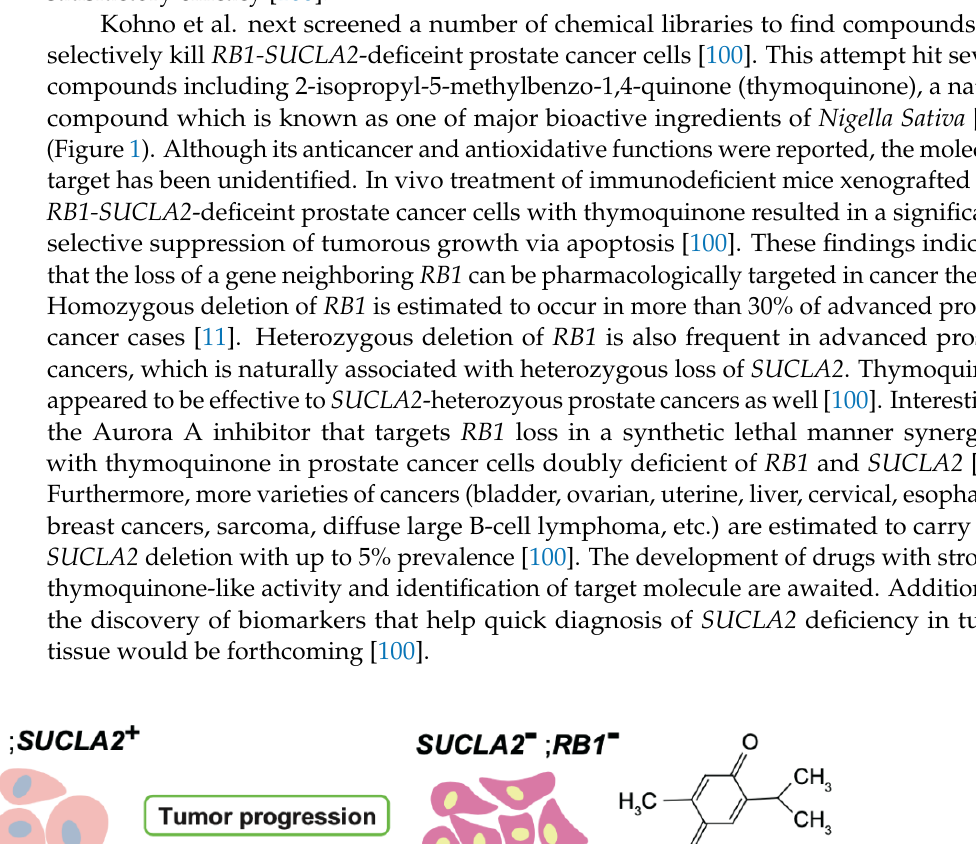
Figure 2. The mechanisms which enable us to target RB1 loss in cancers. TME: tumor microenviron- ment; CIN: chromosomal instability. Author Contributions: P.L., S.K., J.S. and C.T. wrote and D.V. edited the manuscript . All other authors provided information necessary for preparing this manuscript. Funding: Japan Agency for Medical Research and Development, 21cm0106182h0006. Acknowledgments: This study was supported by Funding Program for Next Generation World- Leading Researchers (LS049) from cabinet office of Japan, Grant-in-Aid for Scientific Research (17H03576, 17K19586, 19K22555 and 20H03509 to CT, and 17K14992 and 20K07612 to SK) from MEXT, Project for Cancer Research and Therapeutic (P-CREATE) (19cm0106164h0001,